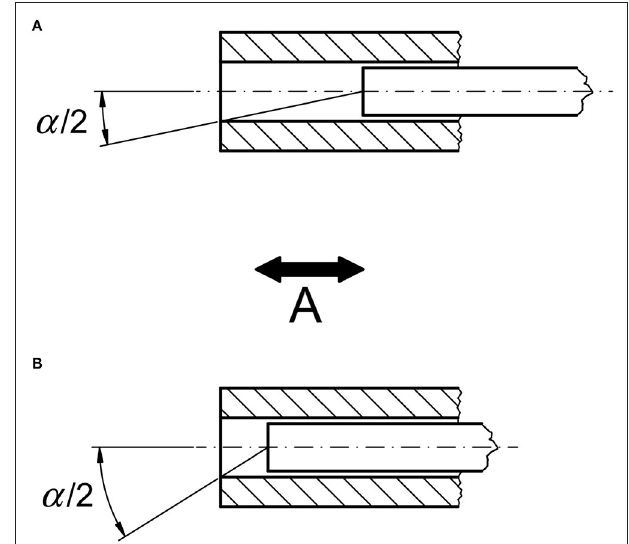
FIGURE 5 | Technically adjustable feature A: Adjustable field of view per pixel. Moving the fiber back and forth along its axis in the tube changes the angle α at which light can enter the fiber. With larger distance between tube end and fiber end shown in (A) , the angle α is smaller than in (B) . For ease of representation, the core diameter of the fiber is assumed to be